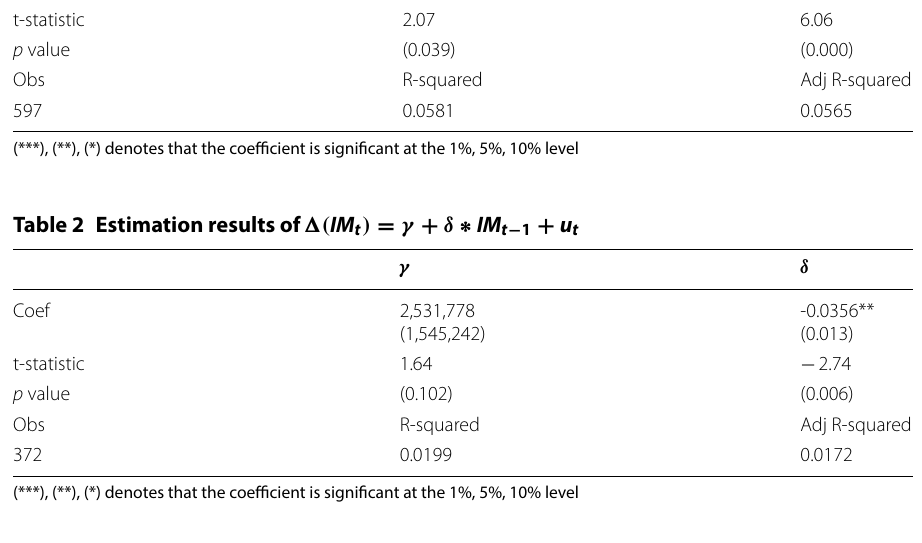
(***), (**), (*) denotes that the coefficient is significant at the 1%, 5%, 10%